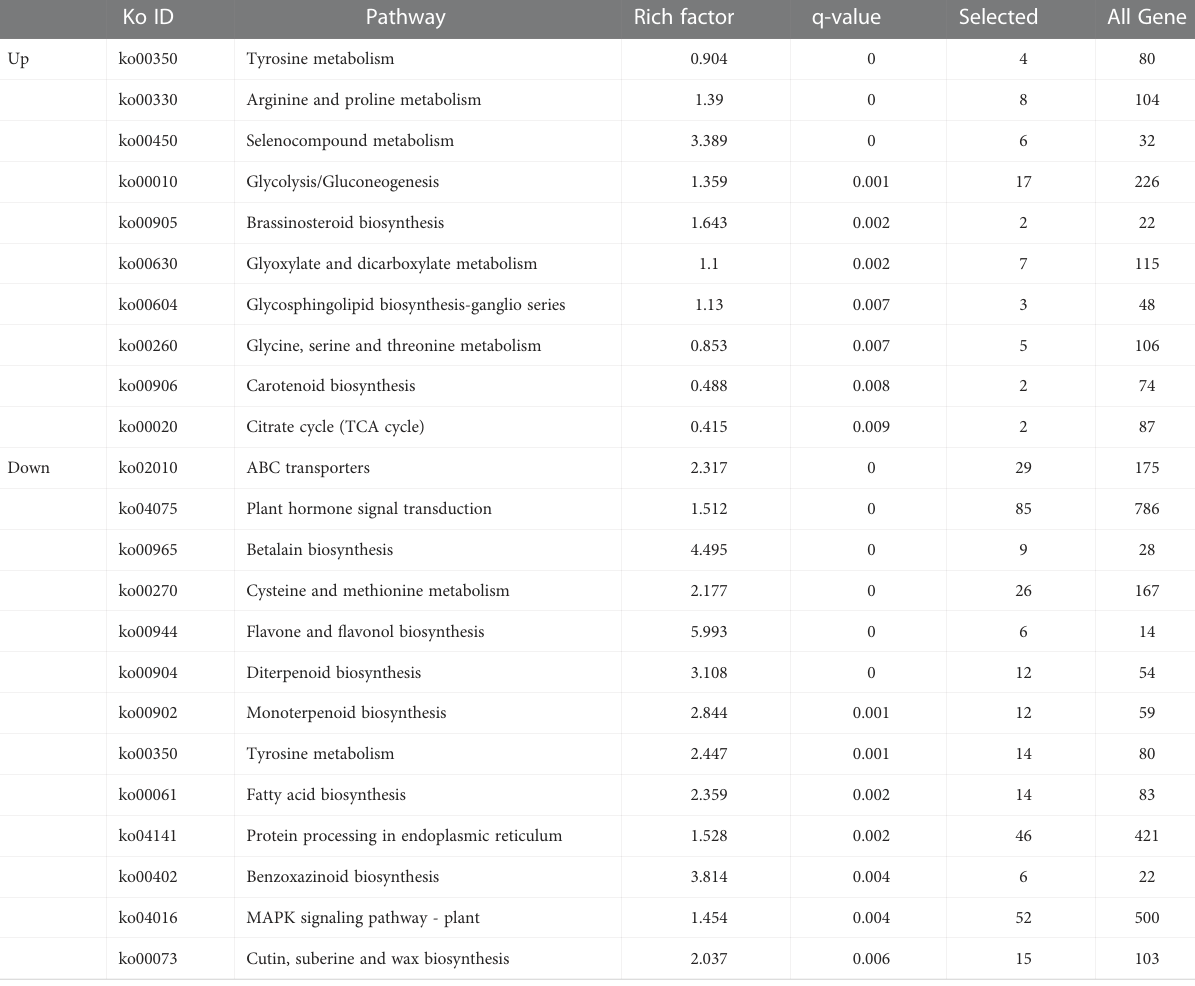
TABLE 2 KEGG enrichment analysis of differentially expressed genes. Ko ID